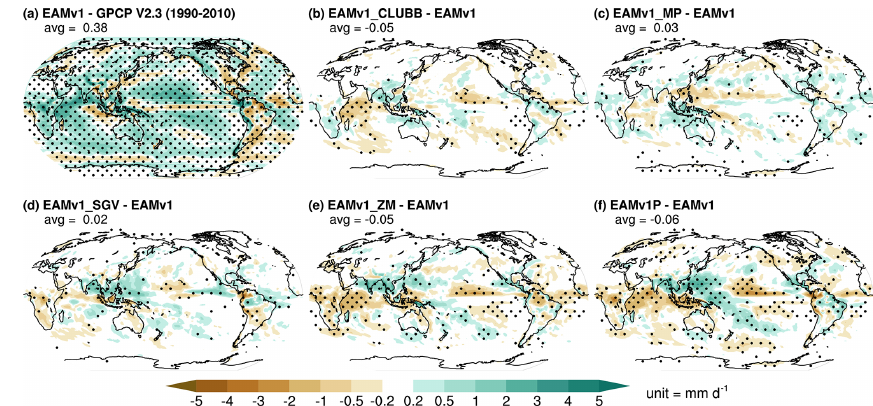
Figure 9. Total precipitation rate differences (unit = mmd − 1 ). The Global Precipitation Climatology Project (GPCP) version 2.3 dataset (Huffman et al., 2001; Adler et al., 2018) is used for the comparison with